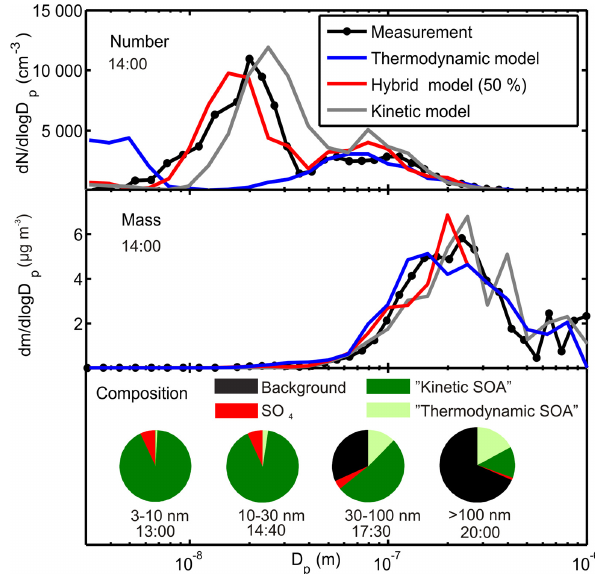
Fig. 6. Predictions of aerosol number (top) and mass (middle) size distributions and jcompositions (bottom) during aerosol growth on 15 April 2007 in Hyyti¨al¨a, Finland. The black curve corresponds to observations, the blue to the case where only sulfuric acid con- denses on the aerosol surface area and the organics are distributed in the pre-existing aerosol mass (“Thermodynamic model”), the red and gray to the cases where 50% (best fit, “Hybrid model”) or 100% (“Kinetic model”) of the total organic flux was distributed to the aerosol surface area. The pie charts indicate the simulated aerosol composition at the time of maximum concentration in 3–10, 10–30, 30–100 and > 100nm particles corresponding for the Hybrid model (50%). “Background” refers to the initial particle size distribution obtained from the DMPS data where the size-dependent composi- tion was